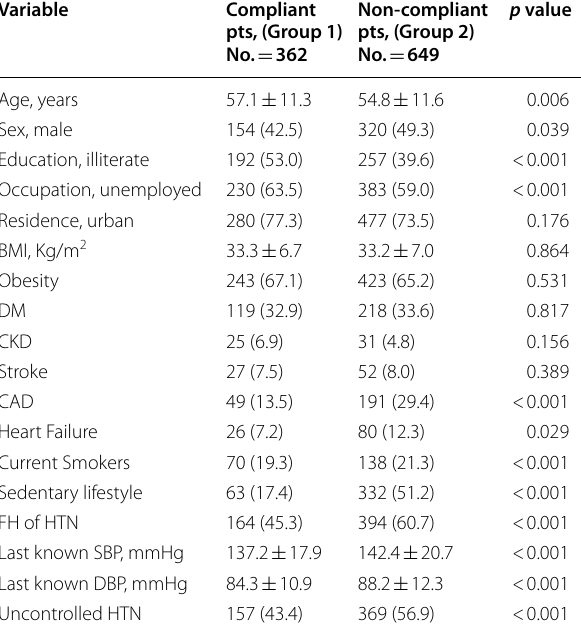
Table 1 Reasons why patients couldn’t be reached through the phone